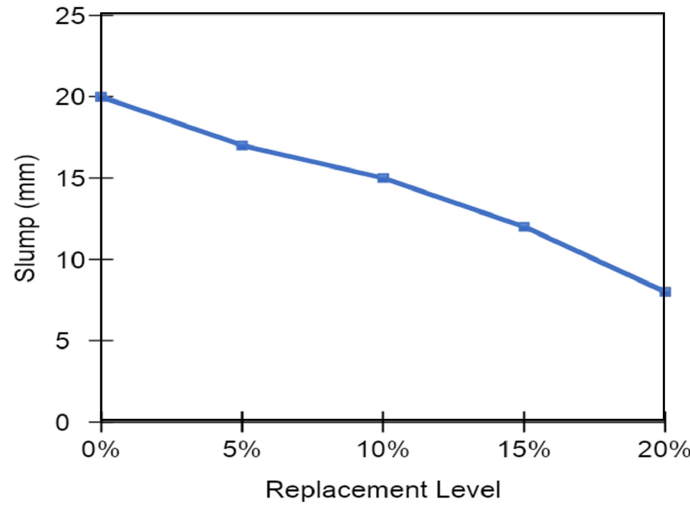
Figure 5. Replacement level versus slump of MK blended